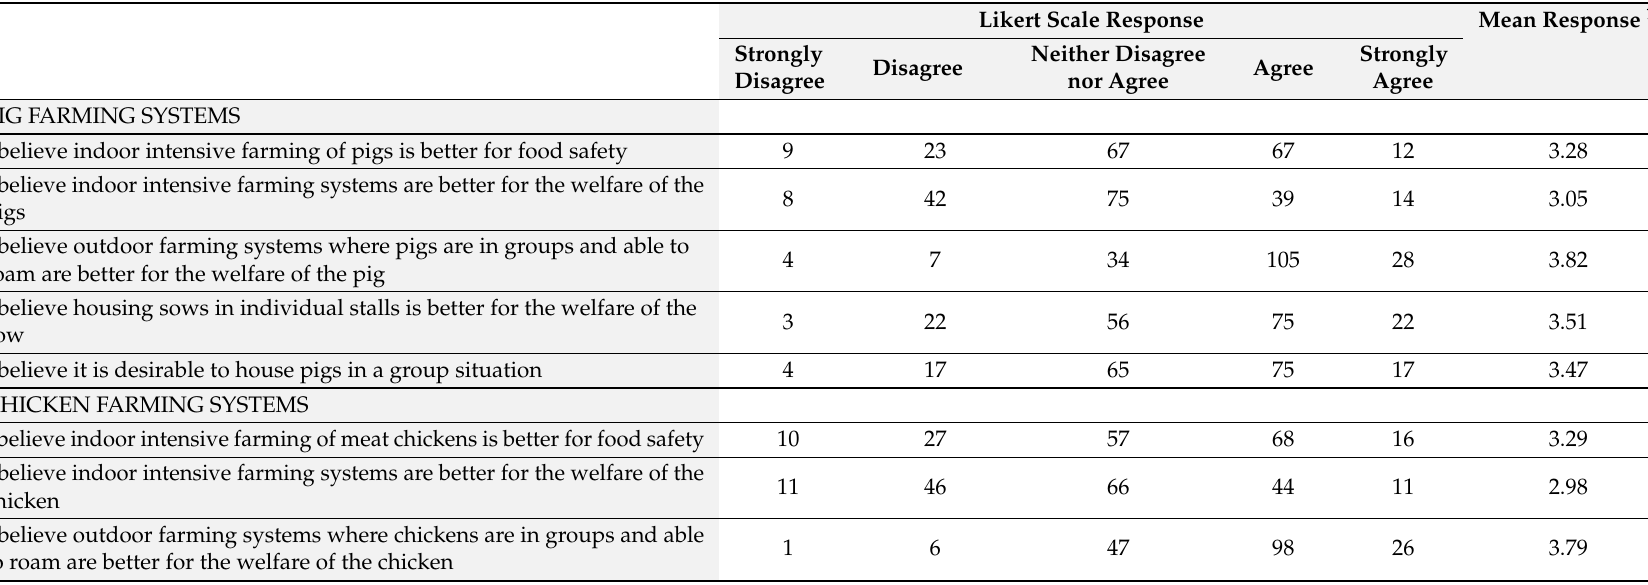
Table 3. Responses to attitude questions about the impact of type of pig and chicken farming system on animal welfare, with di ff erences between mean responses.